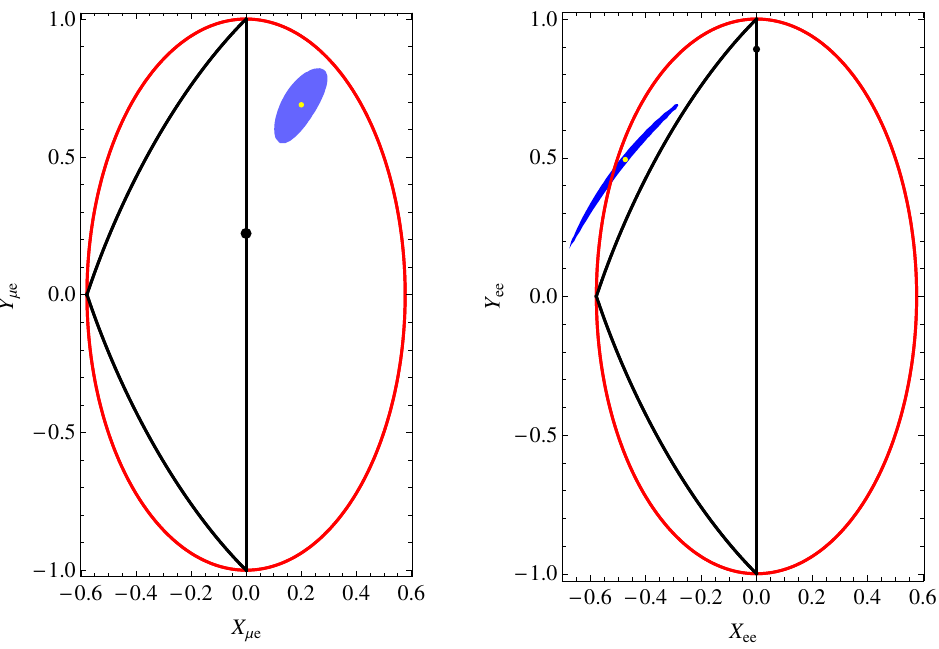
Figure 8 . Future constraints from elastic neutrino scattering experiments in the (cid:22)e channel (left) and the ee channel (right). We assume the actual values of ( X; Y ) are located at the yellow points, and the uncertainties of the future experiments are reduced by a factor of 3 or 4 with respect to CHARM-II or TEXONO, respectively. Other details are the same as (cid:12)gure 5. depend on the Dirac/Majorana nature of neutrinos, as shown in (cid:12)gure 1 or (cid:12)gure 2 in terms of two ratios ( X; Y ) de(cid:12)ned from ( A; B; C ). Therefore the Dirac and Majorana